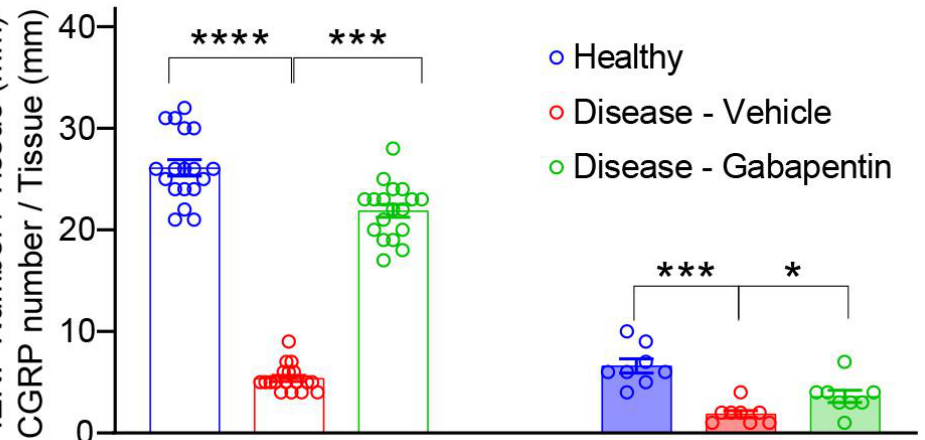
Figure 4. Quantification of immunohistochemically staining of IENF (left) and CGRP-I/II (right) density in skin biopsies of healthy, Taxol-treated (disease-vehicle) and gabapentin-treated mice (disease-gabapentin). The epidermal total (IENF) and CGRP-peptidergic nerve fiber innervation density (mean +/ − SEM) on day 21 were measured and expressed as the number of IENF (left bars) and CGRP (right bars) per length of the section (IENF/mm, n = 9; CGRP/mm, n = 4); The level of significance (*) assumed was 5% (* p ≤ 0.05 ); 0.1% (*** p ≤ 0.001 ); 0.01% (**** p ≤ 0.0001 ); one-way ANOVA followed by Dunn’s post-test.